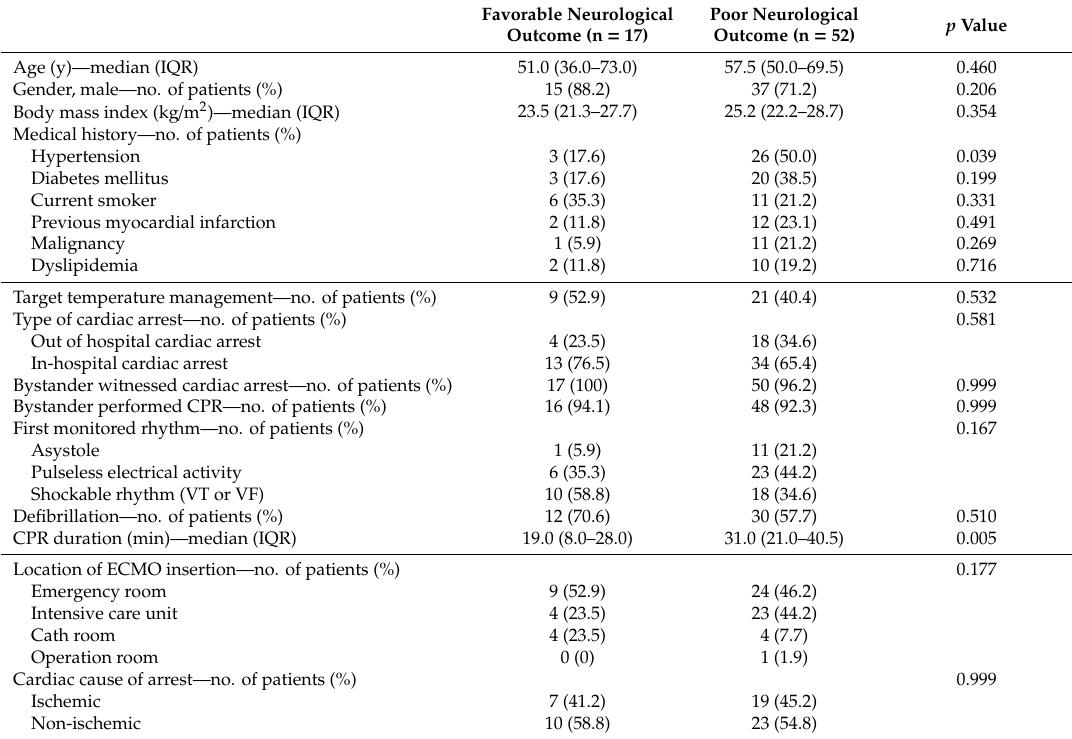
Table 1. Baseline